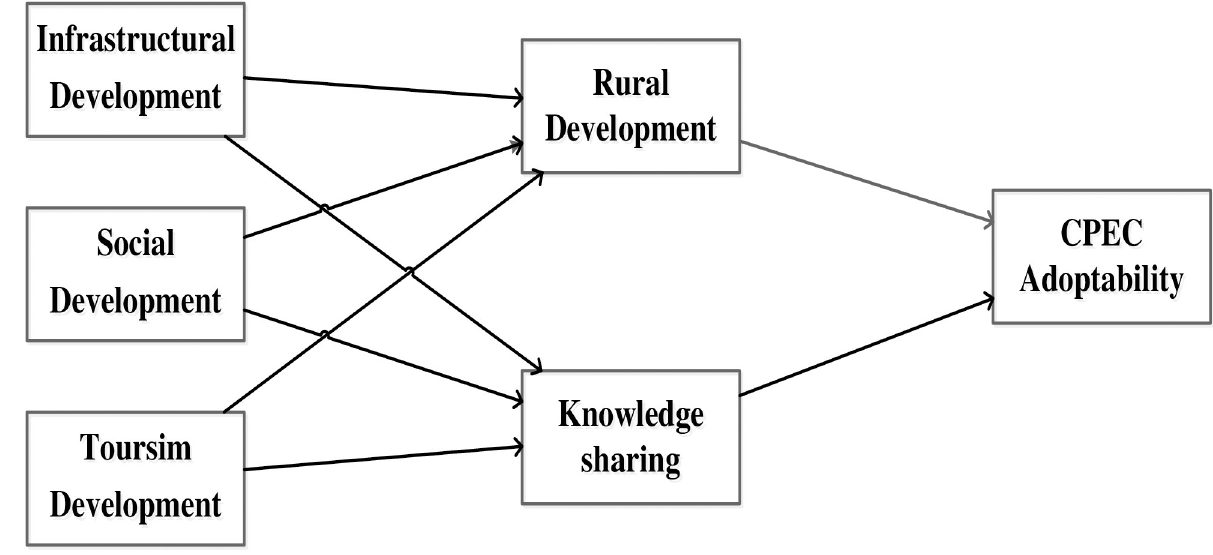
Fig 2. The proposed conceptual framework and hypothesis relationship of the